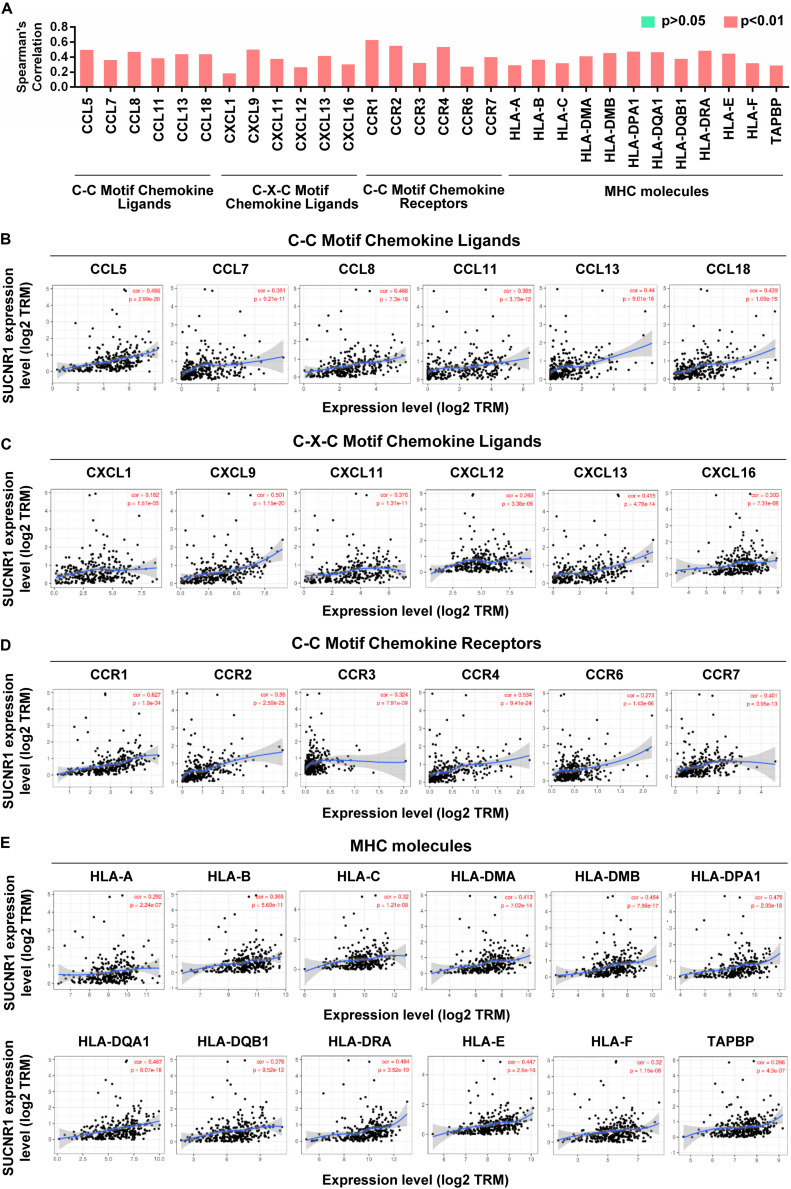
The expression of SUCNR1 is associated with chemokines and MHC molecules in ovarian cancer. (A) The summary of the correlation of SUCNR1 expression with chemokines and MHC molecules. (B–D) Correlation of SUCNR1 expression with C-C motif chemokine ligands, including CCL5, CLL7, CCL8, CCL11, CCL13, and CCL18 (B), C-X-C motif chemokine ligands, including CXCL1, CXCL9, CXCL11, CXCL12, CXCL13, and CXCL16 (C), and C-C motif chemokine receptors, including CCR1, CCR2, CCR3, CCR4, CCR6, and CCR7 (D), in ovarian cancer are available on the TIMER database. (E) Correlation of SUCNR1 expression with MHC molecules, including HLA-A, HLA-B, HLA-C, HLA-DMA, HLA-DMB, HLA-DPA1, HLA-DQA1, HLA-DQB1, HLA-DRA, HLA-E, HLA-F, and TAPBP, in ovarian cancer are available on the TIMER database. Correlation coefficients (rho values) and p values were shown.